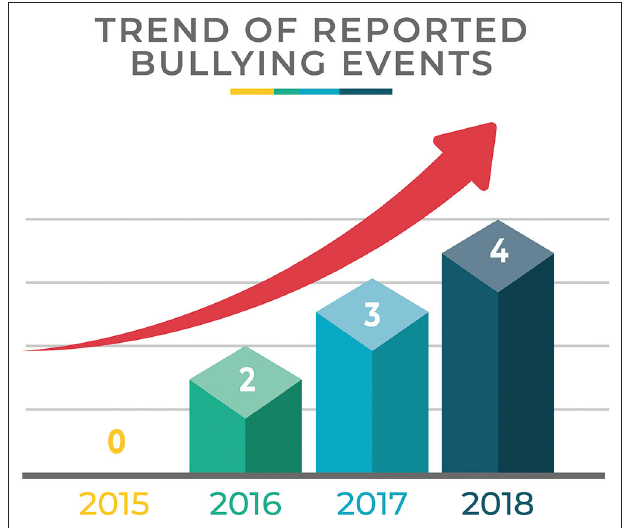
FIGURE 2 | Number of reported bullying events per